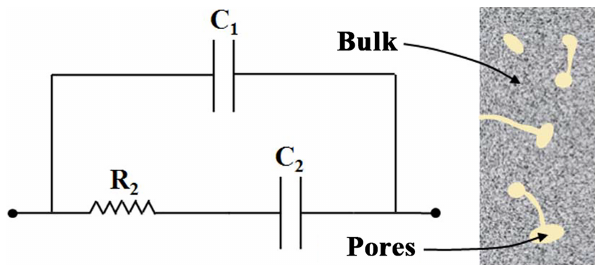
Figure 10. Equivalent circuit used to investigate the hardening pro- cess of cement paste.